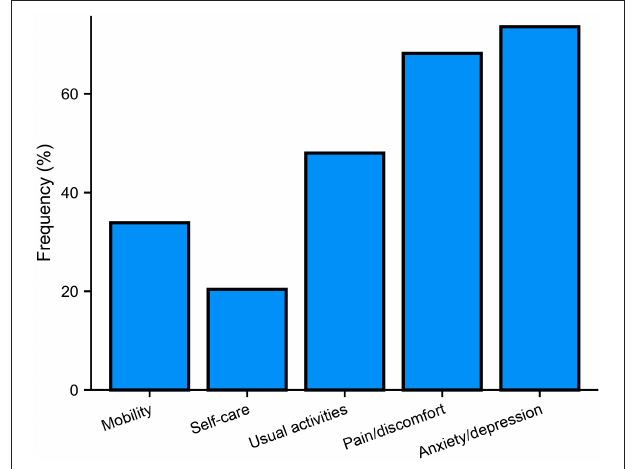
FIGURE 1 | Frequency of reported problems for each of the EQ-5D-5L dimensions.